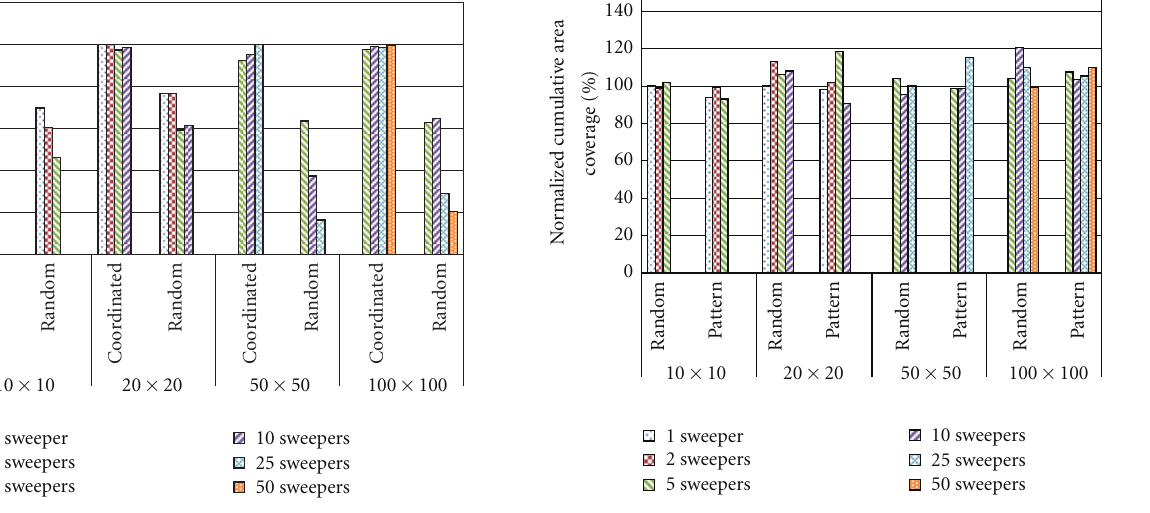
Figure 9: Area coverage in random versus pattern-based distribu- tion model.